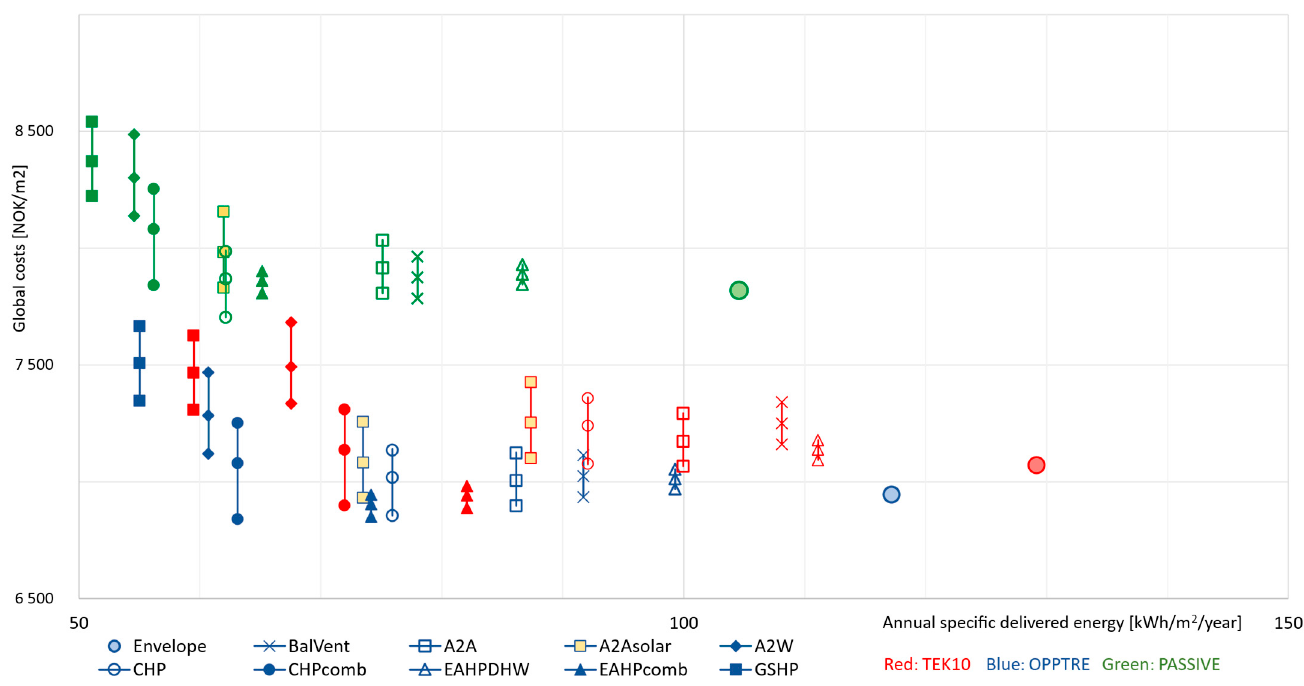
Figure 15. Global costs in the Kristiansand house, assuming hydronic distribution already in- stalled.